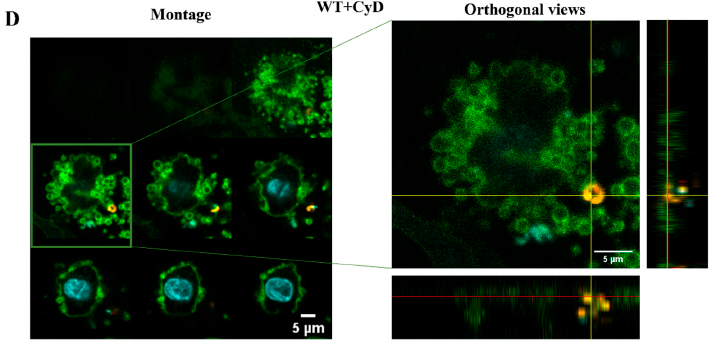
Figure 7. Inhibition of the cytoskeleton rearrangement causes impaired phagocytosis of wild-type L. casei BL23 by moDCs. Five-day moDCs were preincubated with 15 µ M cytochalasin D (CyD) or the vehicle control DMSO for 30 min. Then, moDCs were activated with four times more mCherry- expressing wild-type bacteria for 24 h. Phagocytosis of the WT bacteria by moDCs was detected by flow cytometry and confocal microscopy. The frequency of the phagocytic moDCs at 37 ◦ C was normalized to ice control and was calculated from 3 independent experiments ± SD ( A ). IDC means the nonactivated moDC. Histogram overlays show one representative experiment ( B ). For the confocal microscopic pictures ( C , D ) the moDCs are labeled with HLA-DQ (green) and DAPI (cyan); mCherry is indicated with yellow. On the left of the figure, montage pictures show the Z-stack images per 1 µ m from the bottom to the top of the cell. On the right of the figure, the orthogonal views of one Z-stack image are presented. The bottom shows the Z-projection in the X–Z direction; on the right is the Z-projection in the Y–Z direction. The red lines indicate the Z-depth of the optical slice and the orthogonal planes of the X–Z and Y–Z projections, respectively. Two-way ANOVA followed by Tukey’s multiple-comparison tests were used in the statistical analysis. The difference between the nontreated and CyD-treated moDCs was statistically significant and defined as **** p < 0.0001.